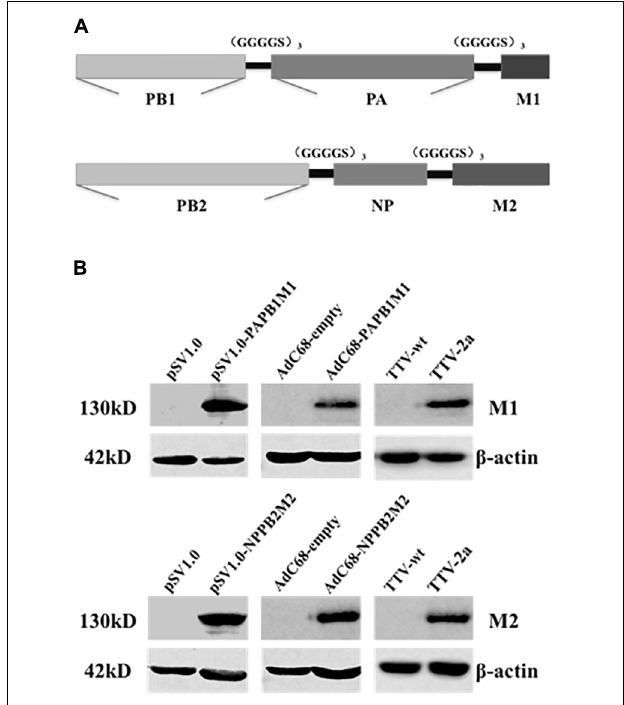
FIGURE 1 | Immunogen design and expression through three different vaccine platforms. (A) Schematic diagram of two synthetic immunogens, PB1PAM1 and PB2NPM2, which were designed on the basis of amino acid conservation and CD8+ T cell epitope prediction of influenza M1, M2, NP, PA, PB1, and PB2 sequences. (B) Validation of vaccine-generated PAPB1M1 and PB2NPM2 protein expression in cultured cells. HEK293 cells were used for the transfection of pSV1.0-based vectors or the infection with AdC68-based vectors, while Vero cells were used for TTV infections. The resulting cell lysates were resolved by denaturing electrophoresis followed by western blotting using antibodies against influenza M1 or M2 protein, or anti- β -actin antibodies as internal control. The cell lysates yielded from transfection or infection of corresponding empty vector were used as negative controls.